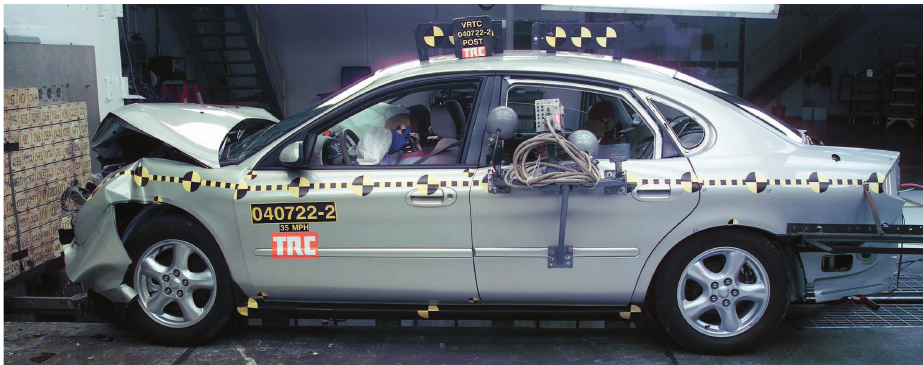
Figure 1. Full-scale crash test of a Ford Taurus (2004 model) at 56 km/h